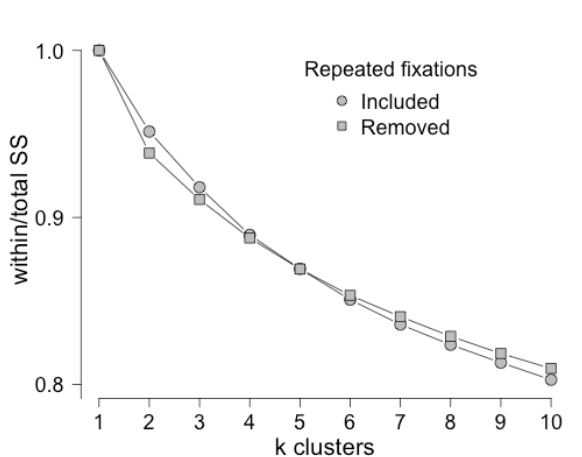
Figure 7. Scree plots from the k -means clustering for the